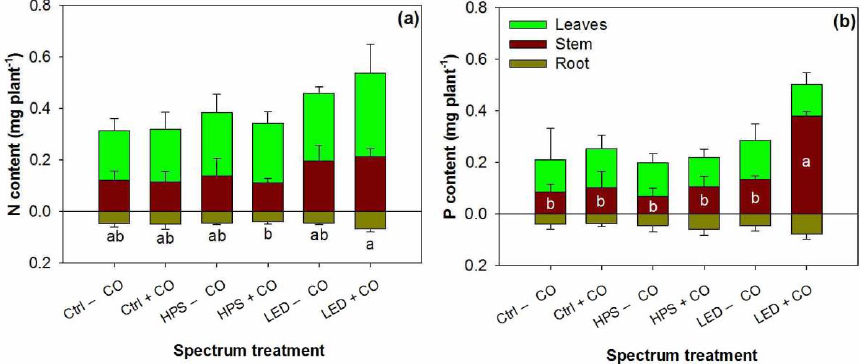
Figure 5. N ( a ) and P contents ( b ) in leaves, stem, and root of Fragrant rosewood ( D. odorifera ) seedlings cultured in the interactive effects of chitosan oligosaccharide addition and lighting spectra. Ctrl, the control of the natural illumination; HPS, high-pressure sodium; LED, light-emitting diodes; − CO, the treatment without chitosan oligosaccharide addition; +CO, the treatment with chitosan oligosaccharide addition. Different letters indicate significant differences at the 0.05 level.